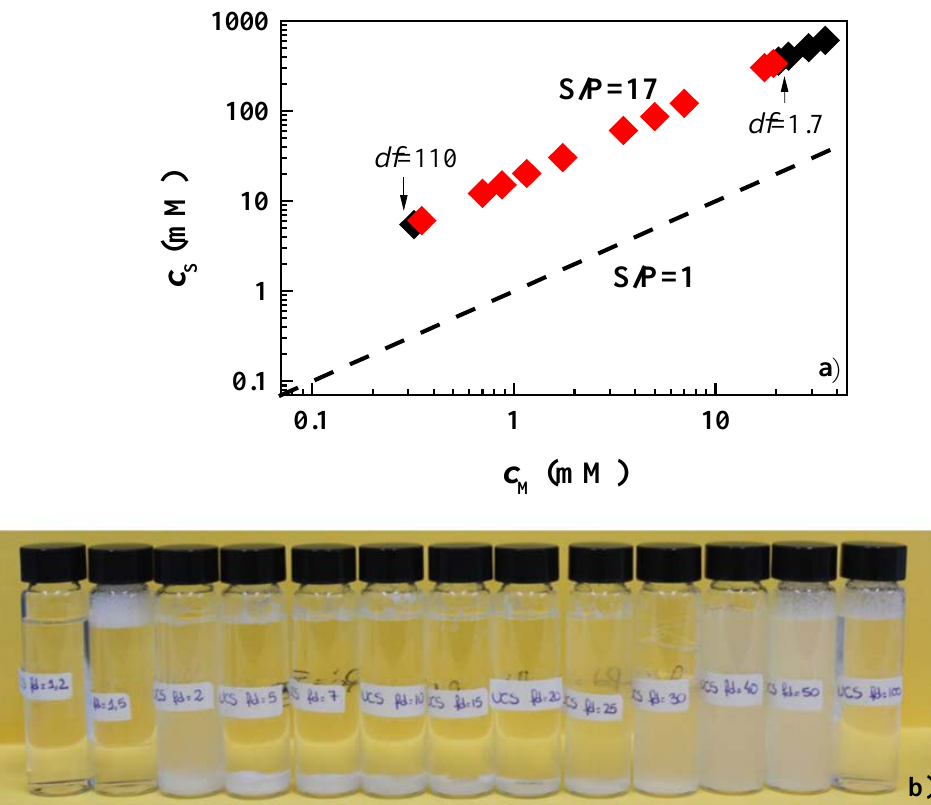
Figure 13. ( a ) Surfactant–polymer concentration phase diagrams for the multicomponent mixture studied. The black and red symbols correspond to one-phase and phase-separate mixtures, respectively, and the discontinuous solid line corresponds to the dilution of a hypothetical mixture with S/P = 1. The value of the dilution factors ( df ) corresponding to the onset and exit of the phase separation region is also indicated. Furthermore, the S/P value corresponding to the dilution line of the sample is also included. Notice that polymer concentration is referring to the total concentration of cationic monomers, including those corresponding to both polymers. ( b ) Image showing the dilution process (from left to right) of the model mixture. The total composition is given in Table 2.